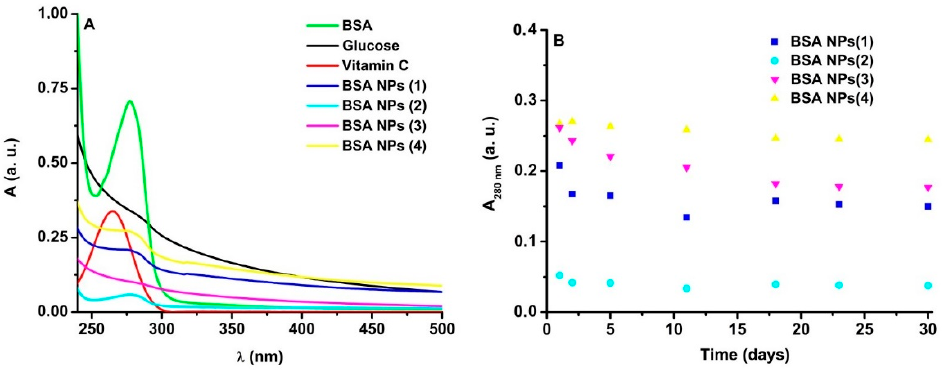
Figure 4. ( A ) UV–Vis spectra of glucose, vitamin C, BSA and all BSA NPs (1)–(4) obtained by the acetone and ethanol methods. ( B ) Time monitoring of the stability of BSA NPs obtained by the desolvating method.